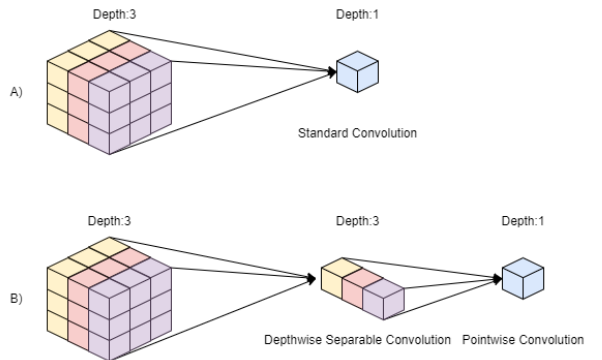
Figure 7. A visual interpretation of ( A ) standard convolution compared to ( B ) depthwise separable convolutions used in MobileNet